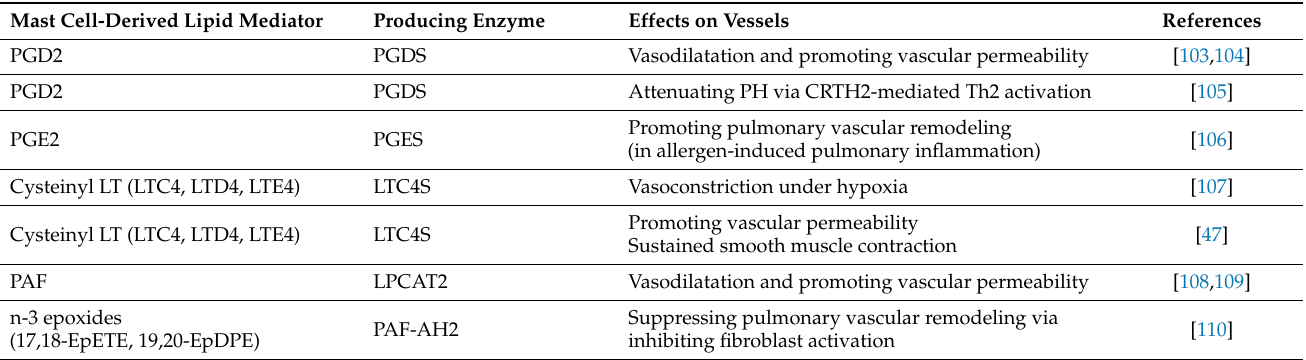
Table 1. Representative mast cell-derived lipid mediators and the effects on vessels. Mast Cell-Derived Lipid